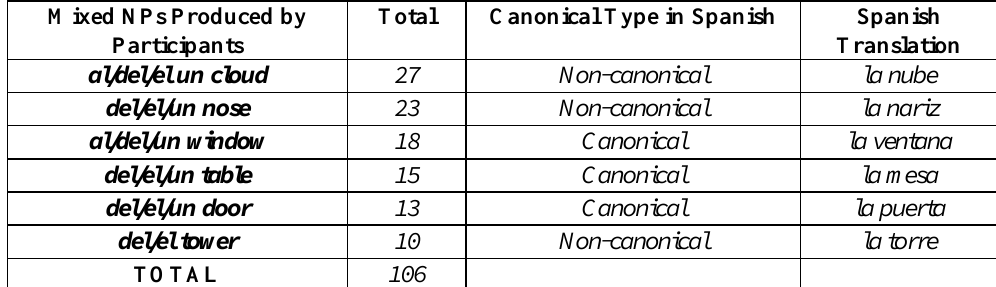
Table 10. Mixed NPs produced with a masculine determiner in the forced toy task (i.e., stimuli with Spanish feminine translation equivalents) Mixed NPs Produced